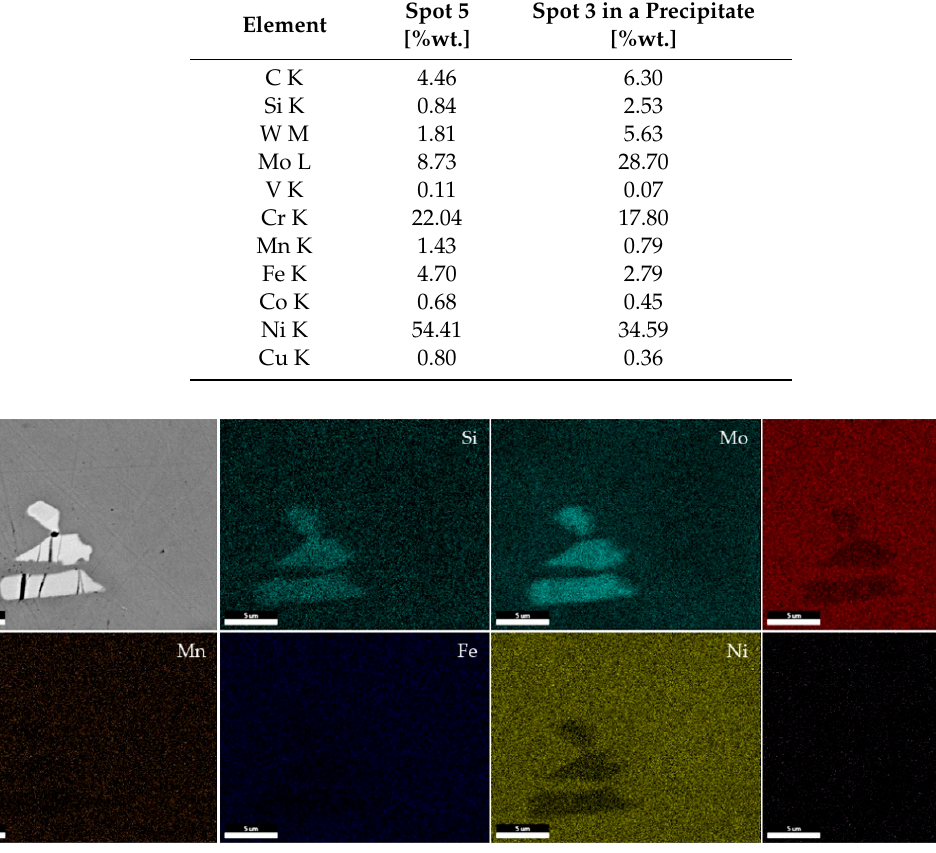
Figure 12. Mapping of specimen in air without thermal treatment (analyzed specimen 1.2): CBS-SEM (upper-left), Si, Mo, Cr, Mn, Fe, Ni, Cu.